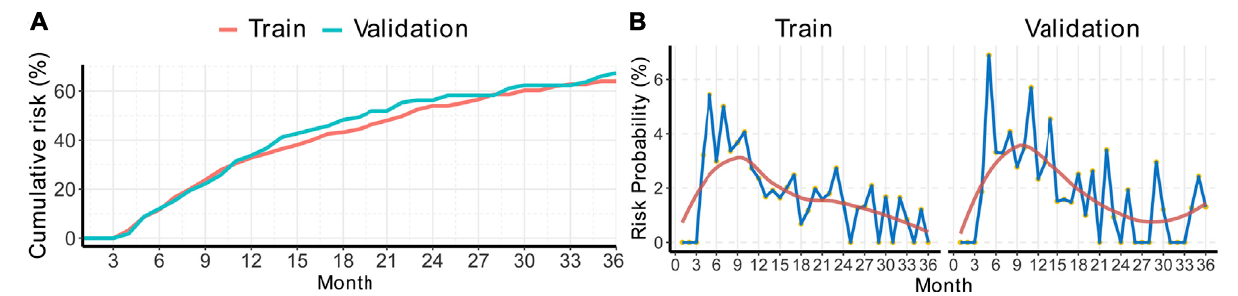
Frontiers in Bioengineering and Biotechnology |